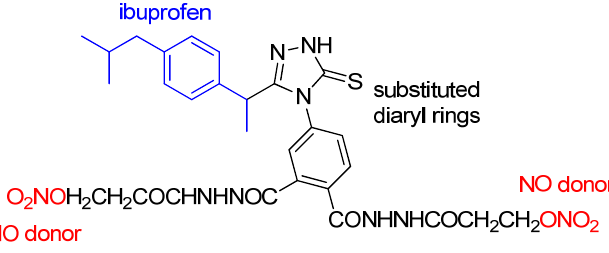
Figure 28. Hybrid compound with pharmacophore moiety of ibuprofen and